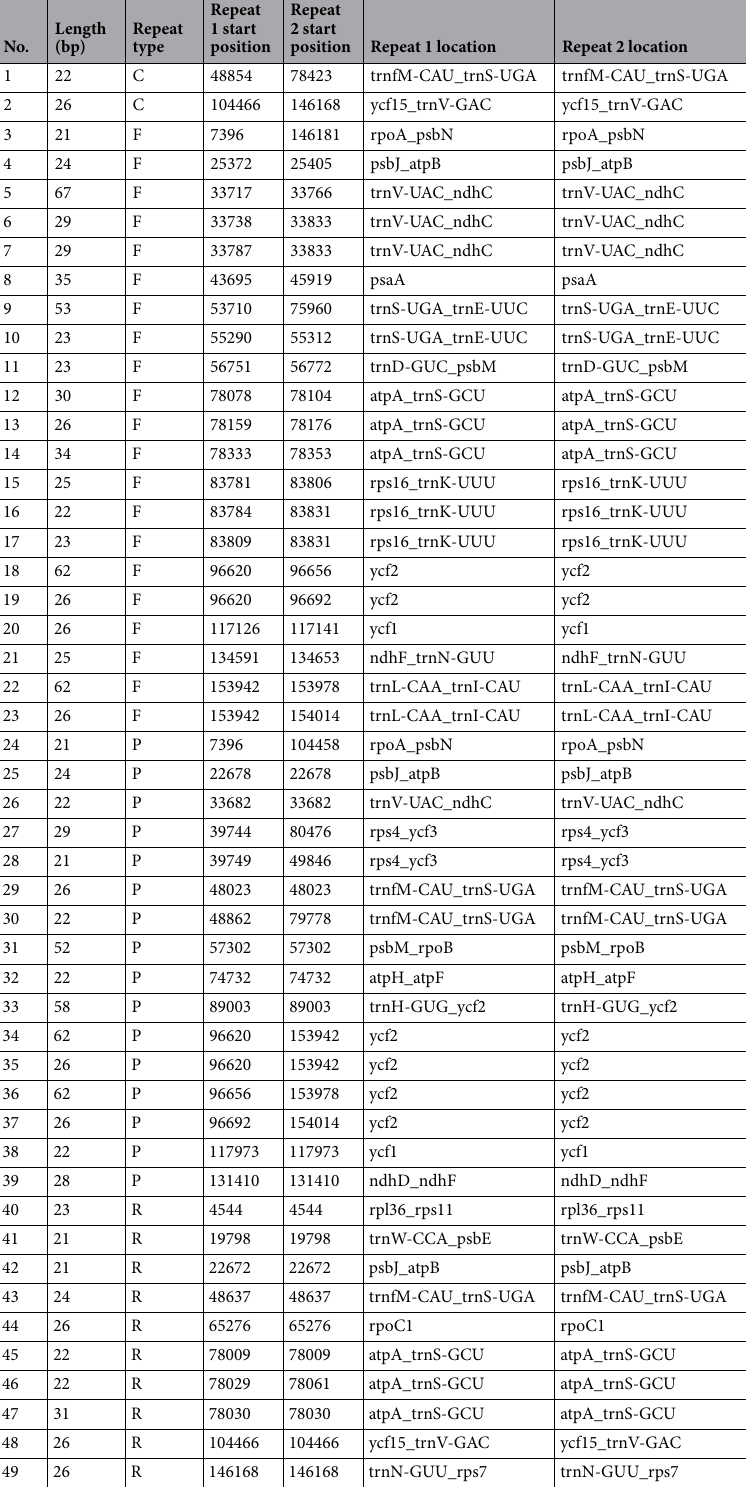
Table 4. Repeat sequences in the tung tree cp genome. C: complement repeats, F: forward repeats, P: palindrome repeats, R: reverse